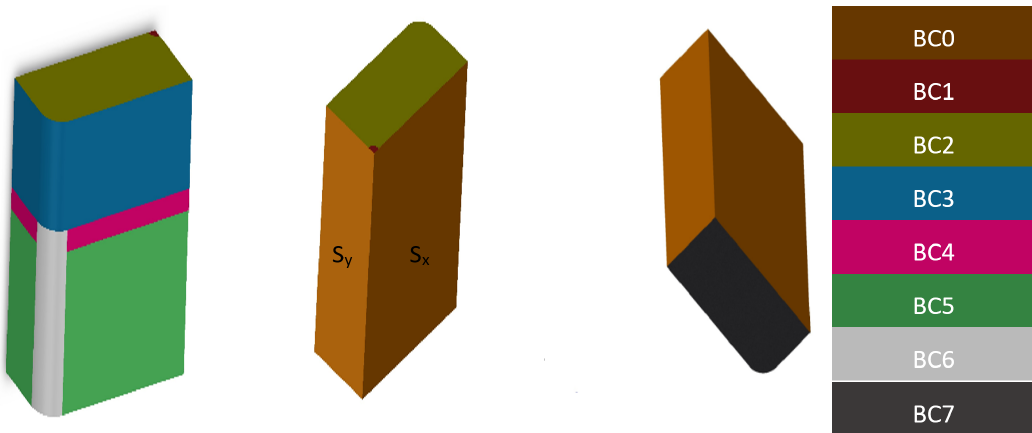
Figure 6. Schematic illustration of thermal conditions in numerical